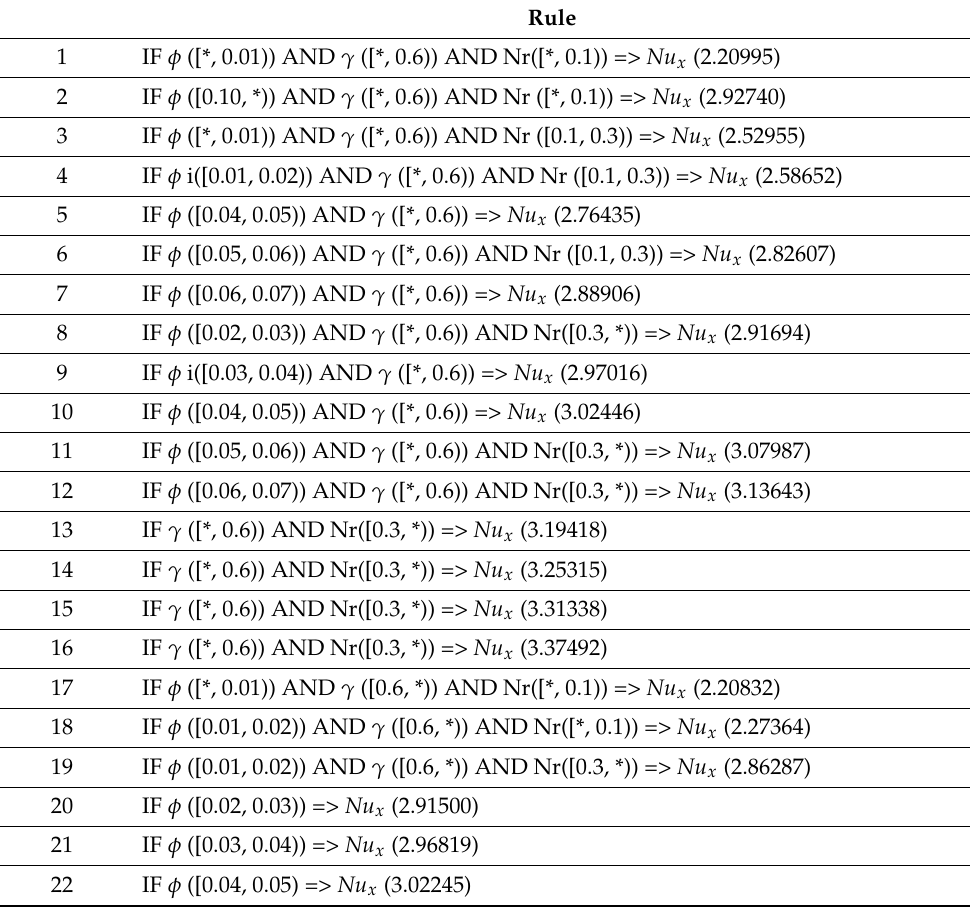
Table 5. The generated rules to predict the value of local Nusselt number Nu x